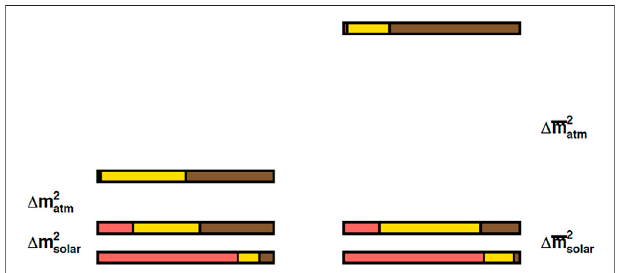
FIGURE 2 | The fi gure illustrates a CPT violating spectrum. A possible overall shift between the neutrino and antineutrinos is omitted since oscillation experiments can ’ t test it. As commented before, the cosmological matter power matter spectrum can do